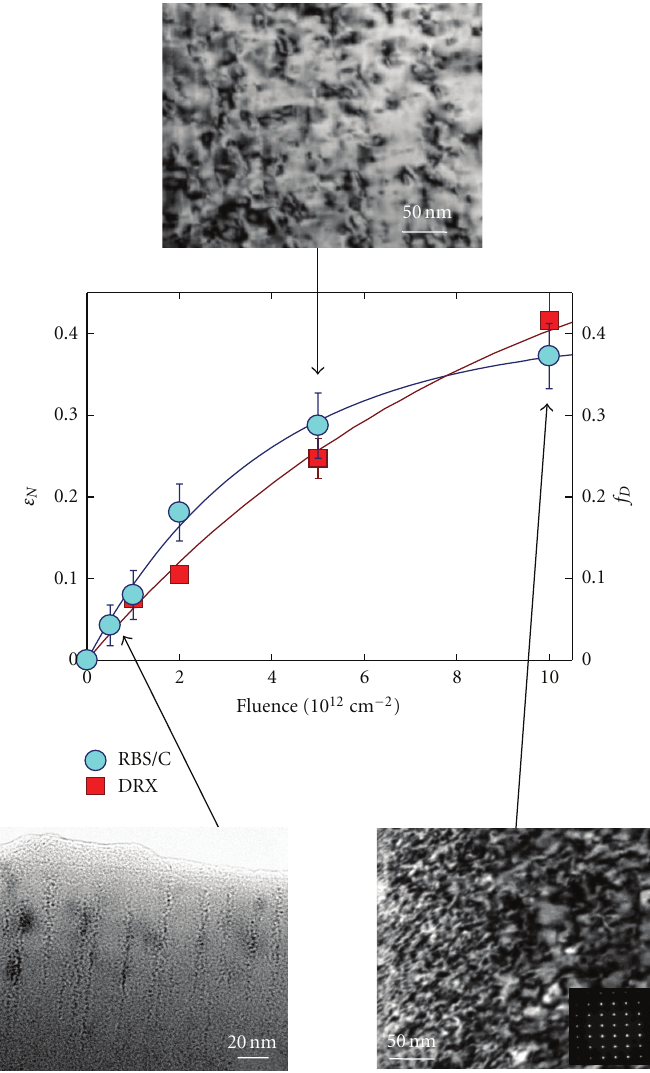
Figure 7: Accumulated damage ( f D ) and elastic strain ( ε N ) versus ion fluence for cubic zirconia crystals irradiated at RT with 940-MeV Pb ions. Solid lines are fits to data using the MSDA model [23, 24]. Insets show TEM micrographs on samples irradiated at fluences indicated by the